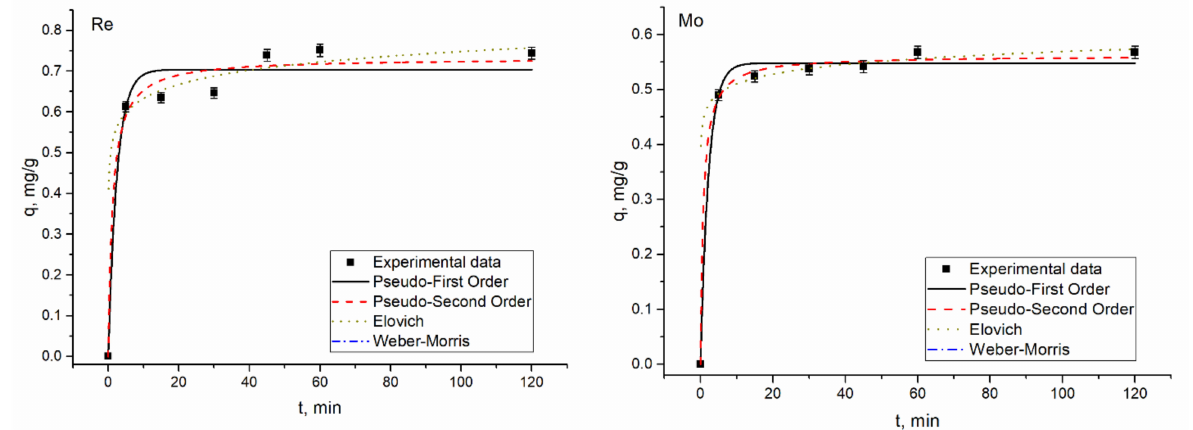
Figure 6. Kinetics of rhenium and copper biosorption on yeast biomass.